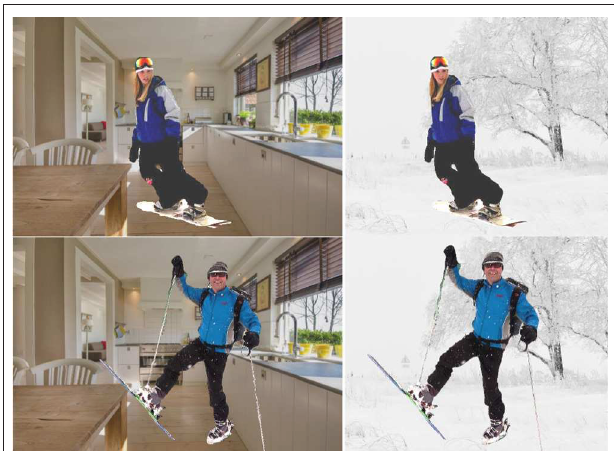
FIGURE 4 | Posters dataset can help test bias. In this example, both contextual and gender bias are tested by placing out-of-context poster-cut-outs. Snowboarding is generally correlated with gender “male” and context “snow” ( Hendricks et al.,